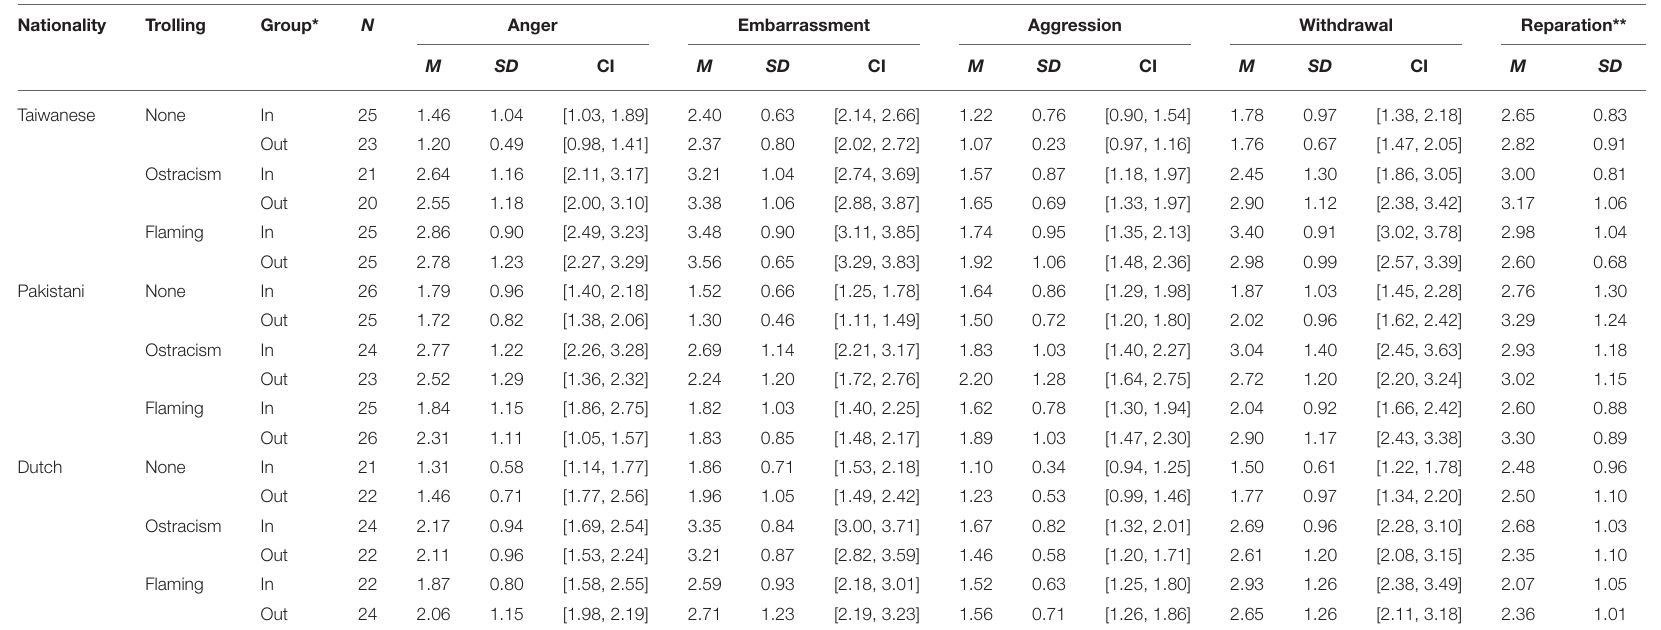
TABLE 1 | Descriptive statistics of within-subjects factors and dependent variables. Nationality